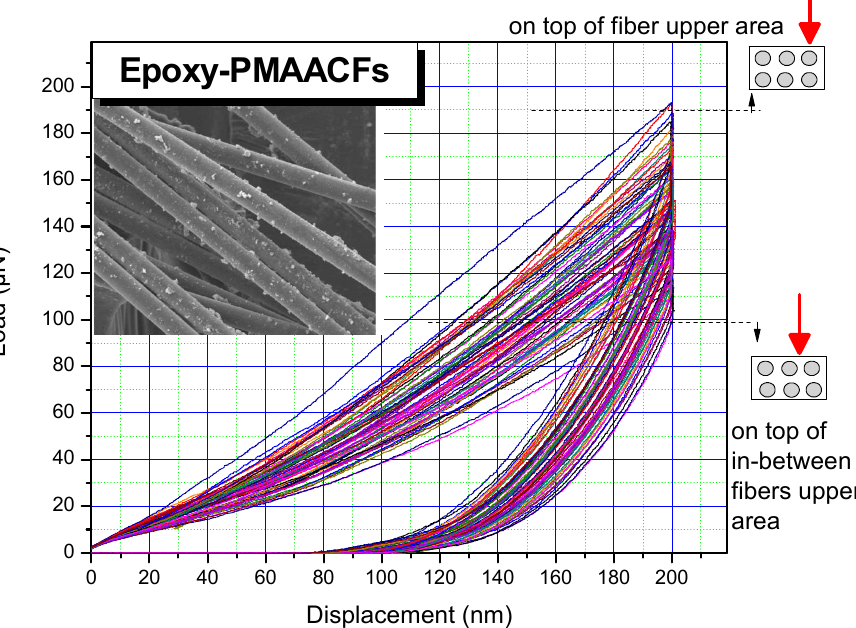
Figure 6. Load-displacement data from the loading-unloading mapping measurements at 200 nm of Figure 6. Load ‐ displacement data from the loading ‐ unloading mapping measurements at 200 nm of displacement, for the epoxy-PMAACFs sample. displacement, for the epoxy ‐ PMAACFs sample.